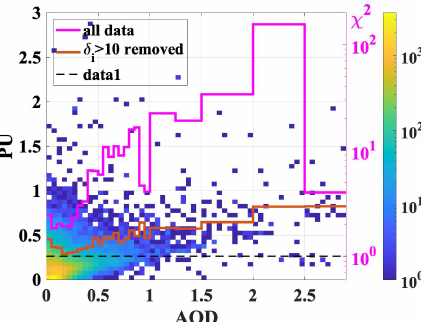
Figure 14. χ 2 for binned aAOD for all available matchups (ma- genta line) and after the outliers of the individual weighted devia- tions ( δ i > 10) are removed (red line). Density scatter plot for PU and